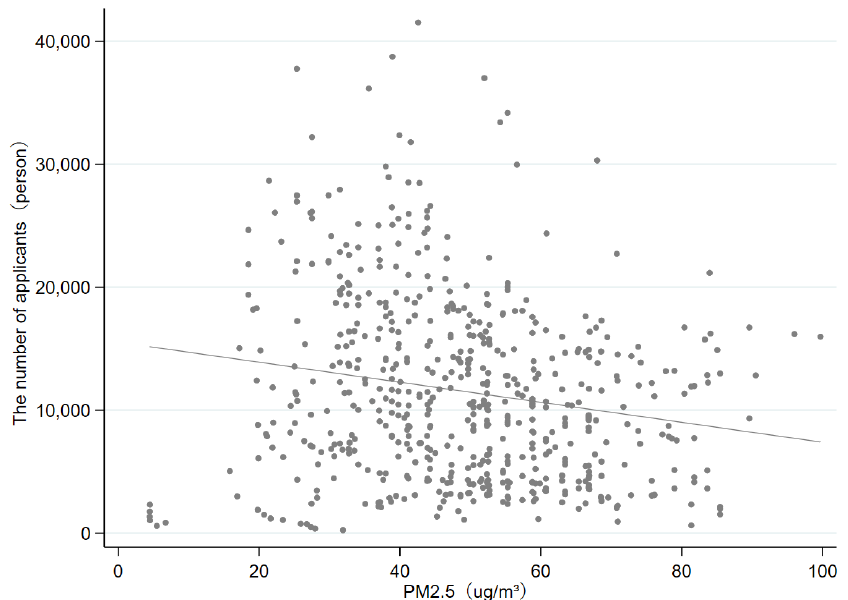
Figure 2. PM 2.5 concentration and the number of applicants. Note: This figure displays the relationship between PM 2.5 concentration and the number of applicants for all sample universities. ship between PM 2.5 concentration and the number of applicants for all sample